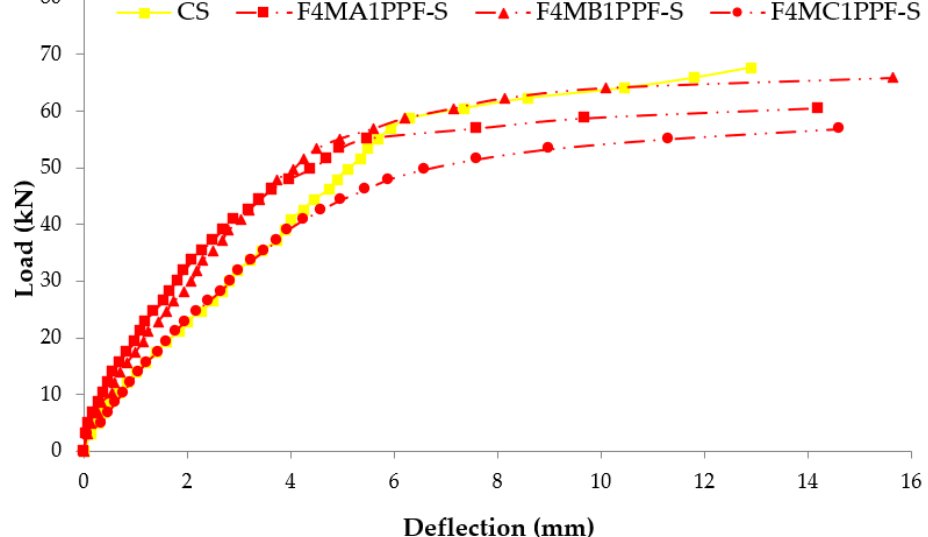
Figure 17. Comparison of load-deflection for different % of PPF and four steel wire mesh.